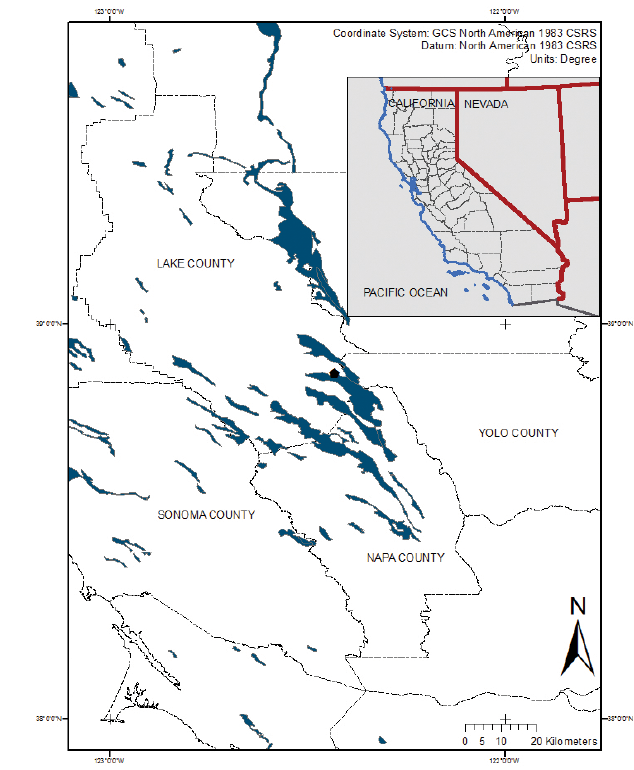
Figure 1. County map of California overlain with serpentinite units colored steel blue in ArcMap10, derived from USGS georeferenced geologic map data (USGS OFR 2005-1305). Drilling took place in Lower Lake, CA in the boundaries of the McLaughlin Natural Re- serve, administered by the University of California at Davis, Lower Lake, CA; this site is shown as a black hexagon near the center of